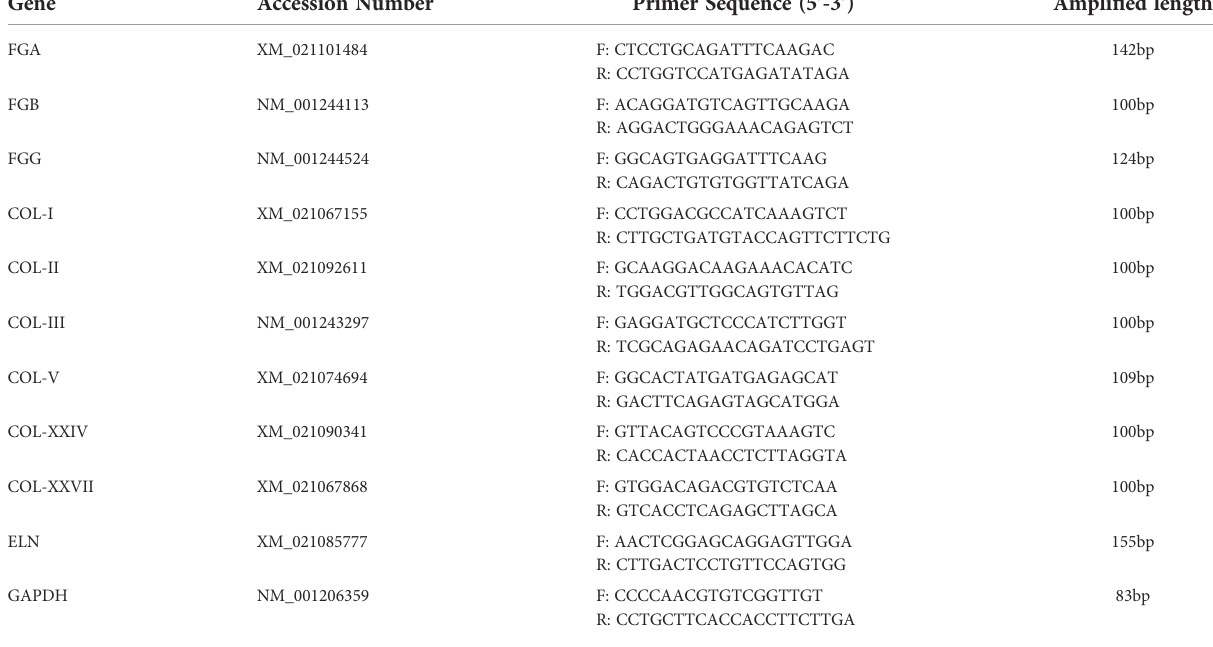
TABLE 1 qPCR primers used in this